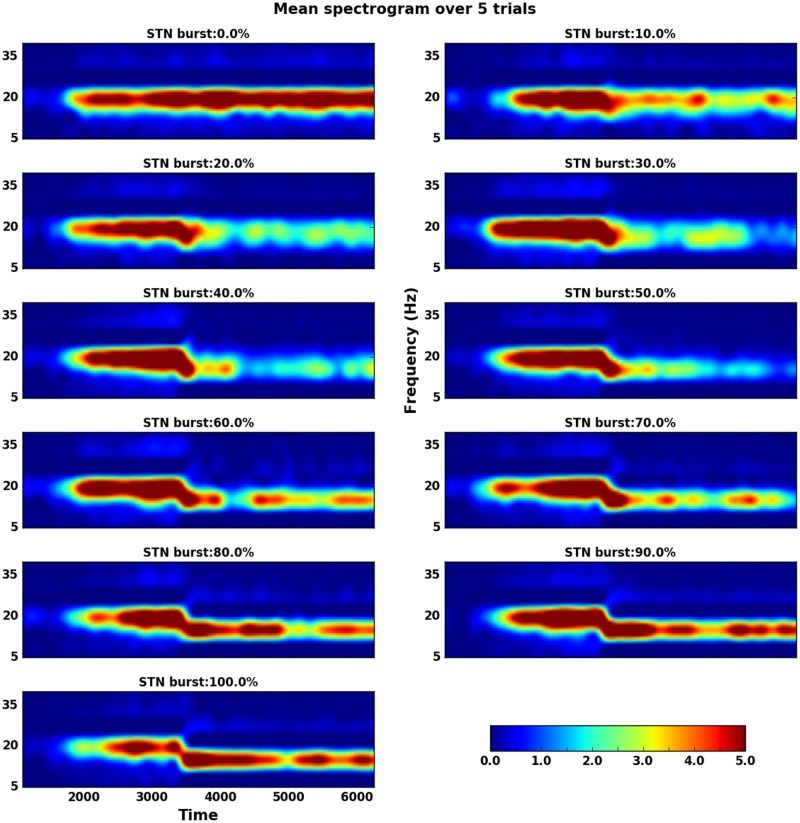
Non-monotonic effect of STN spike bursting on network oscillations when the network operates in the transition regime.Here the fraction of bursting neurons in the GPe was fixed to 40% of GPe neurons and the fraction of bursting neurons in the STN (FBSTN) was increased systematically (as marked on different subplots). 40% of GPe neurons were made to elicit spike bursts from time point 1500 ms. This resulted in emergence of oscillations. A fraction of STN neurons (FBSTN marked on each subplot) were made to burst, starting at time 3500ms. For small to moderate FBSTN, oscillations disappeared. But when FBSTN was larger oscillations reappeared albeit at a lower frequency. The spectrograms shown here were averaged over 5 trials of the network with different random seeds.